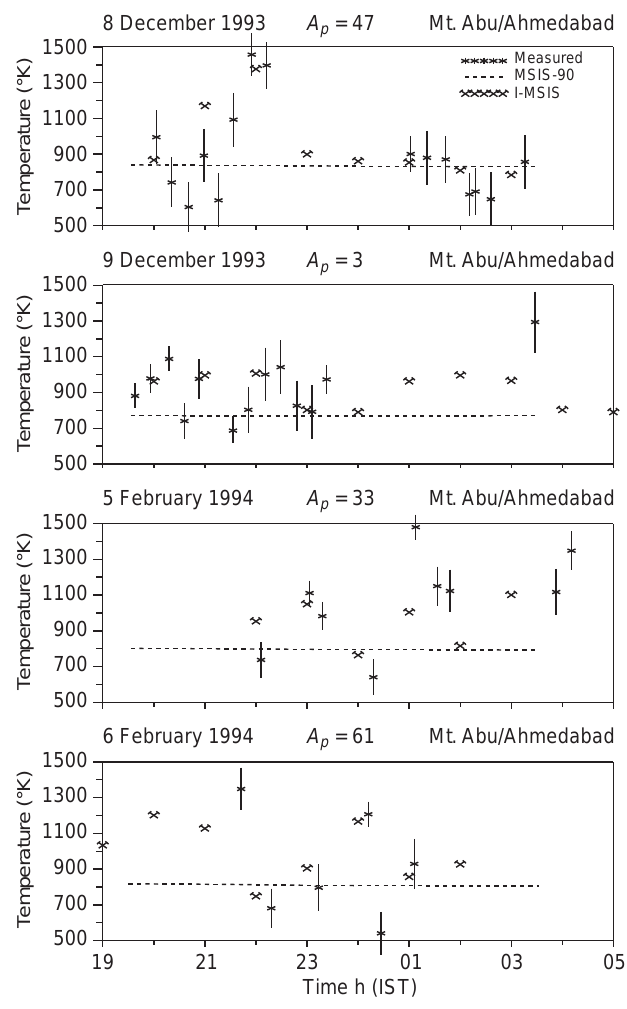
Fig. 2. Variation of spectroscopically measured thermospheric temperatures from Mt.Abu ( dots with error bars ) along with MSIS- 90 model prediction ( dashed line ) for di(cid:128)erent days under consider- ation (the date and the Ap values are shown on top of the panel ). It can be seen that the improved MSIS values ( crosses ) agree well with the measured temperatures.